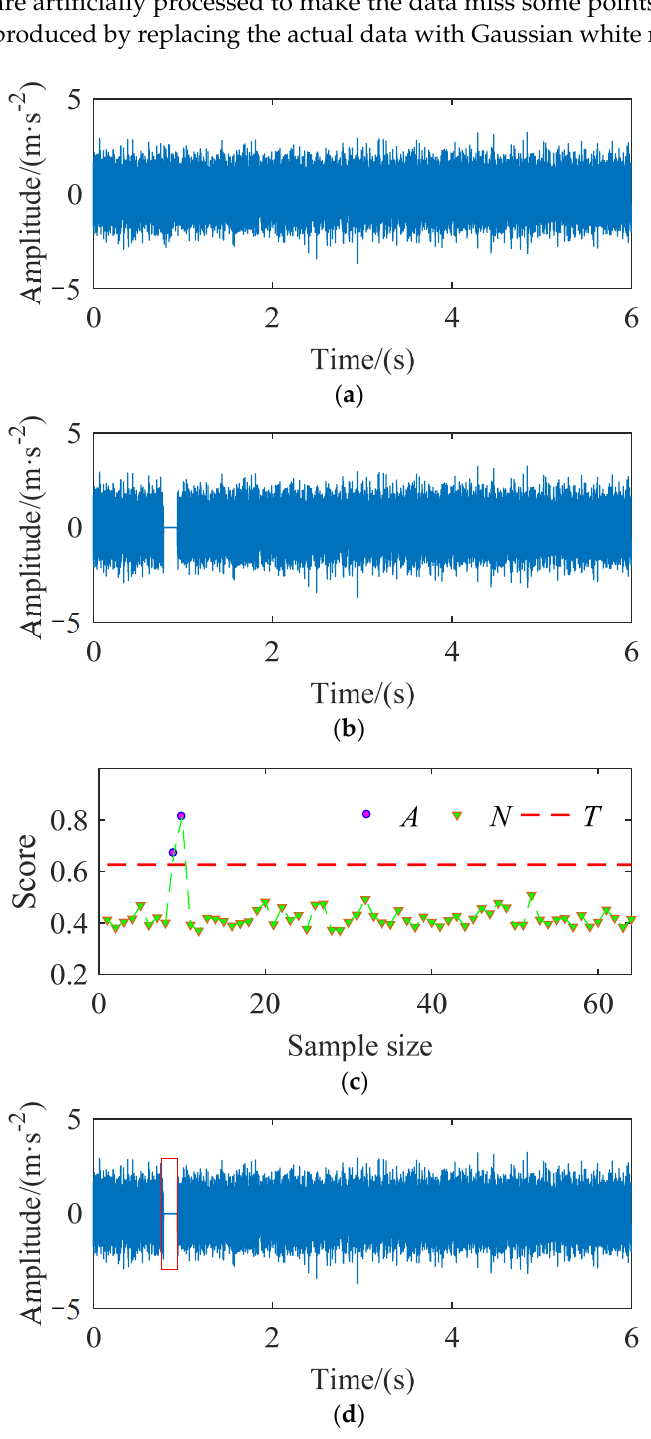
Figure 9. Detection result with CF-POIF. ( a ) complete signal; ( b ) signal with missing segment; ( c ) abnormal score; ( d ) detection result.